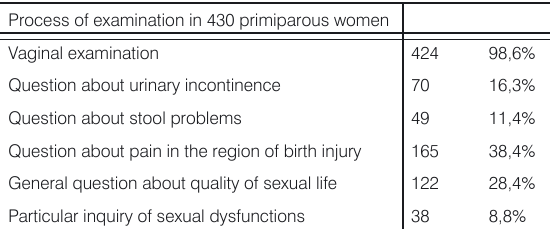
Table 1. Frequency of some parts of routine examination of women after the